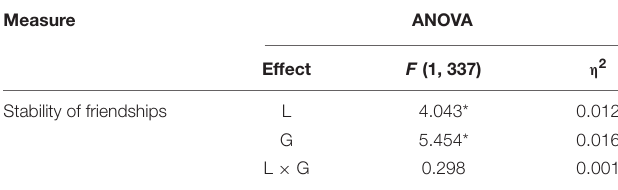
TABLE 8 | ANOVA statistics on friendship